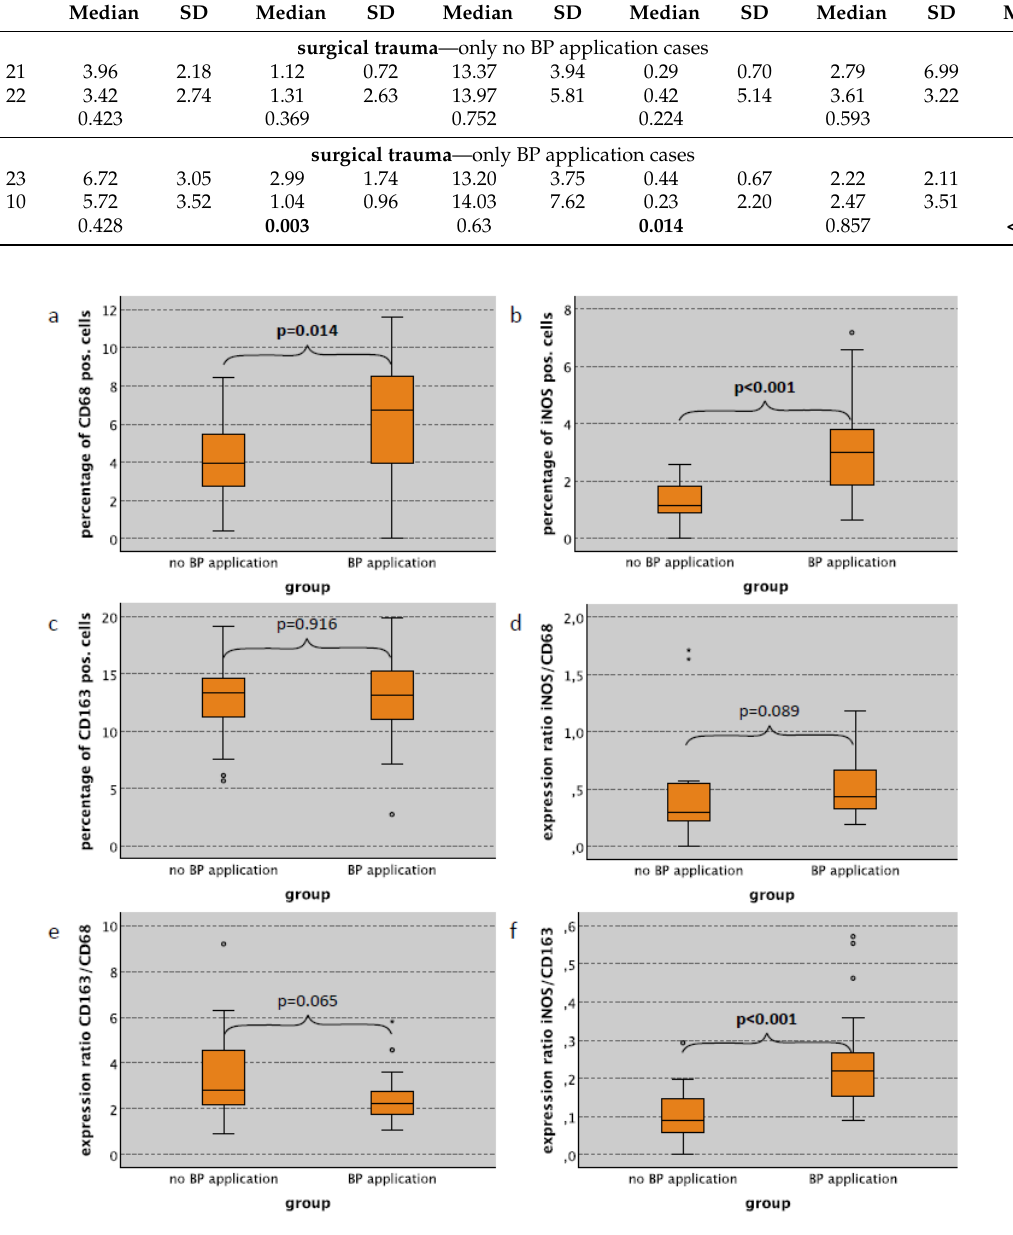
Figure 1. Influence of bisphosphonate application on macrophage infiltration and polarization in subepithelial skin tissue without surgical trauma. Expression of macrophage markers and the correlation to the bisphosphonate (BP) application in the subepithelial layer of the skin (skin subepithelium) of rats without surgical trauma. ( a ) Percentage of CD68 pos. cells depending on BP application (pos. cells/all cells in %). ( b ) Percentage of iNOS pos. cells depending on BP application (pos. cells/all cells in %). ( c ) Percentage of CD163 pos. cells depending on BP application (pos. cells/all cells in %). ( d ) Expression ratio of iNOS and CD68 depending on BP application ((iNOS pos./all cells)/(CD68 pos./all cells)). ( e ) Expression ratio of CD163 and CD68 depending on BP application ((CD163 pos./all cells)/(CD68 pos./all cells)). ( f ) Expression ratio of iNOS and CD163 depending on BP application ((iNOS pos./all cells)/(CD163 pos./all cells)). For statistical analysis, the Mann-Whitney-U-Test was used. Significant p -values ( p < 0.05) are indicated in bold letters. * p < 0.05, ** p <